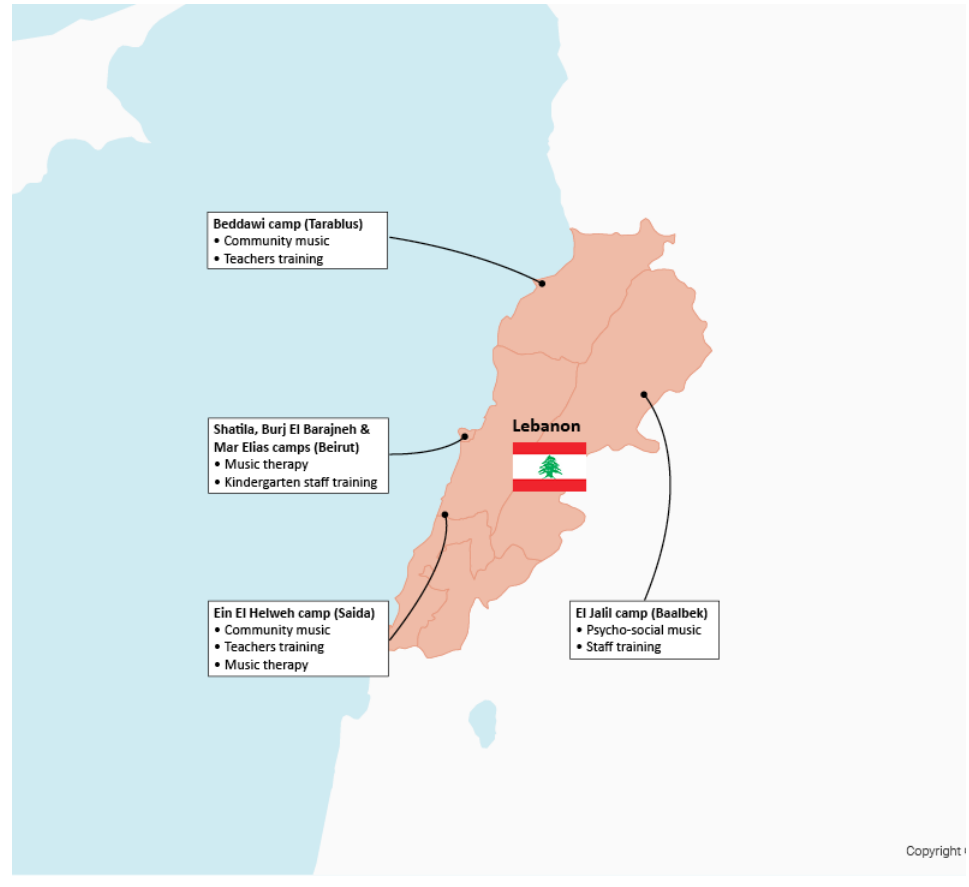
FFigigururee 33 Location of camps where M&R is